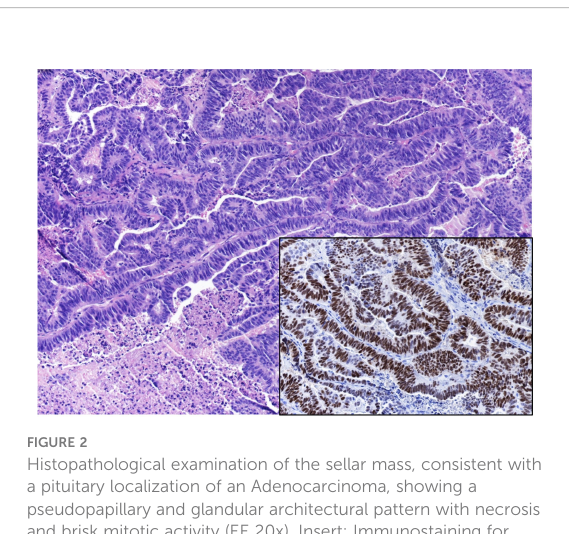
FIGURE 2 Histopathological examination of the sellar mass, consistent with a pituitary localization of an Adenocarcinoma, showing a pseudopapillary and glandular architectural pattern with necrosis and brisk mitotic activity (EE 20x). Insert: Immunostaining for CDX2